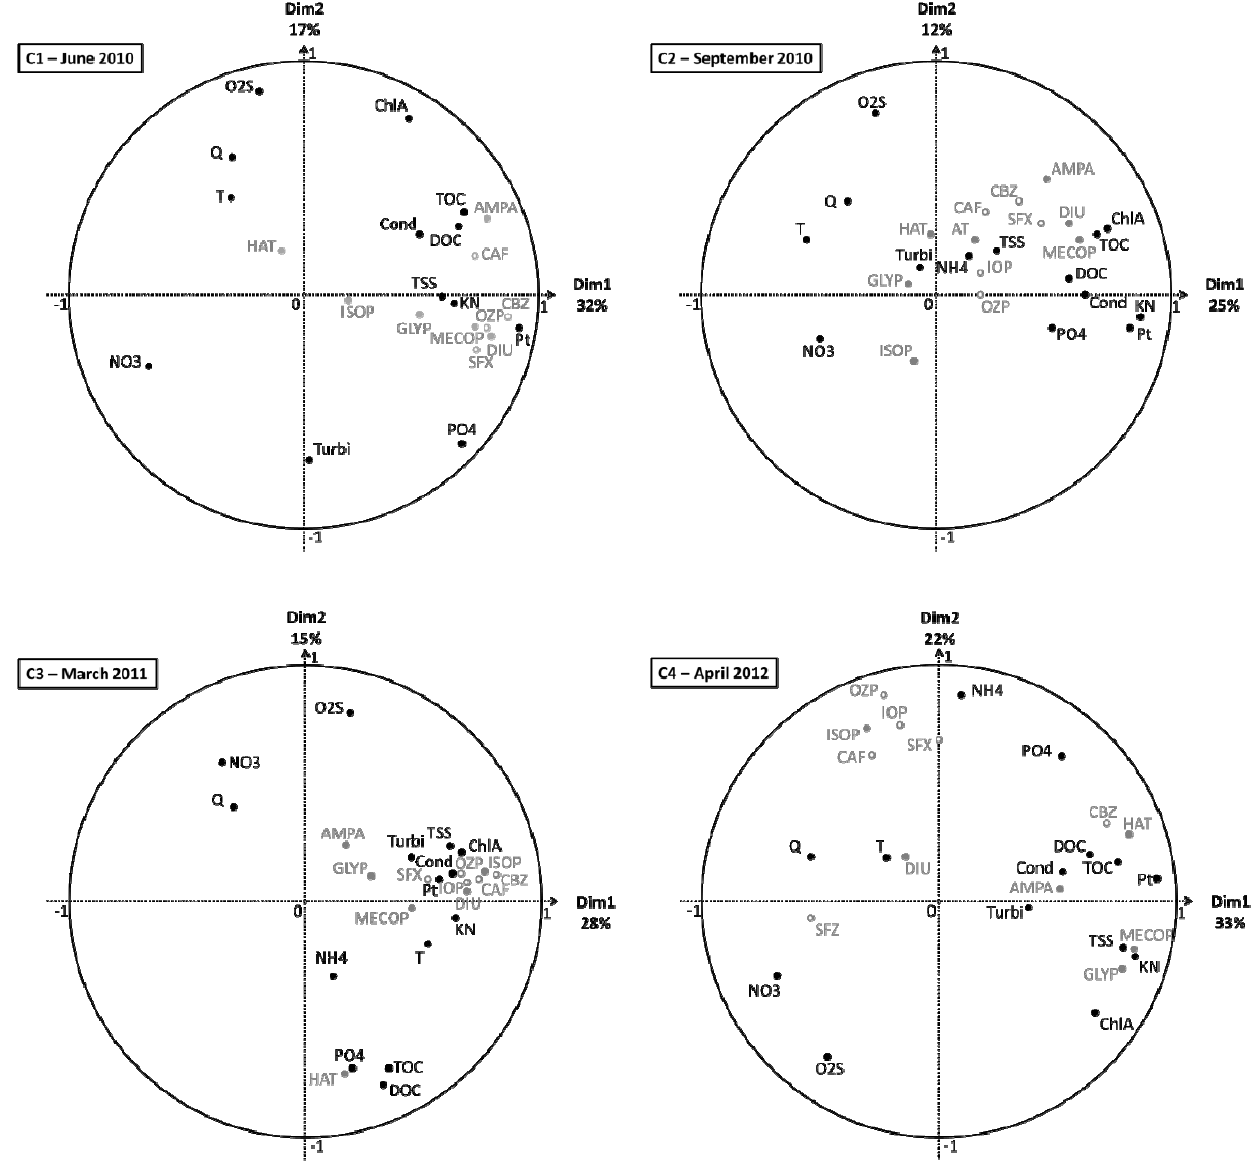
Figure 4. Results of the PCA of the four campaigns (experimental datasets); physicochemical and hydroclimatic parameters are in black and micropollutants in grey. (NH : ammonia, KN: Kjeldhal nitrogen, NO 4 phosphorus, TOC: total organic carbon, DOC: dissolved organic carbon, TSS: total suspended solid, Turbi: turbidity, ChlA: chlorophyll A, O conductivity, Q: daily flow, T: